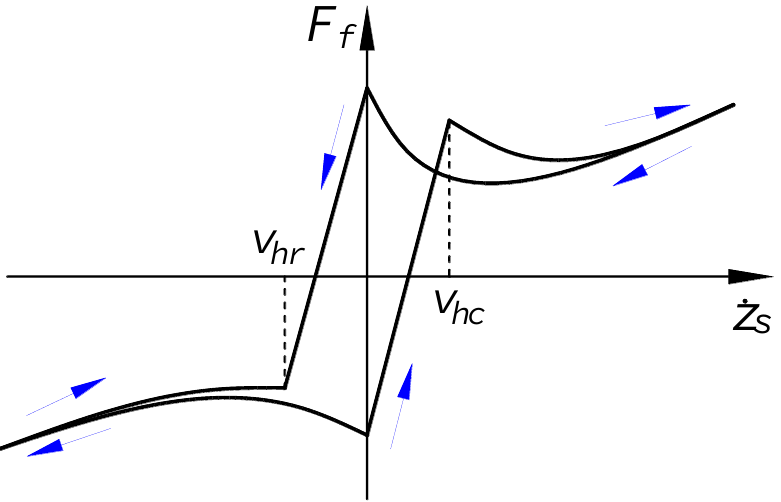
(cid:12) (cid:12) (cid:12) (cid:12) . . z s z s (cid:12) (cid:12) < v hc or (cid:12) (cid:12) < v hr for